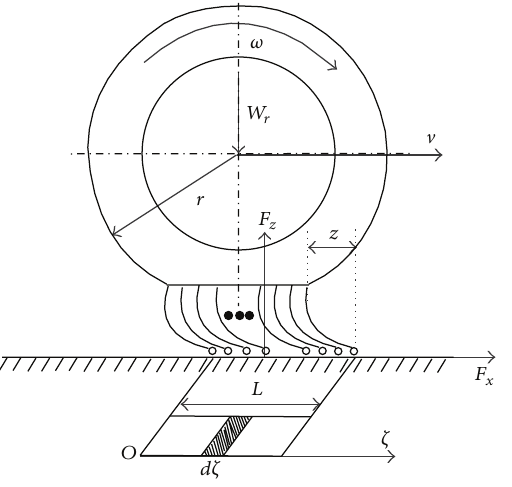
Figure 12: The LuGre tire property for different